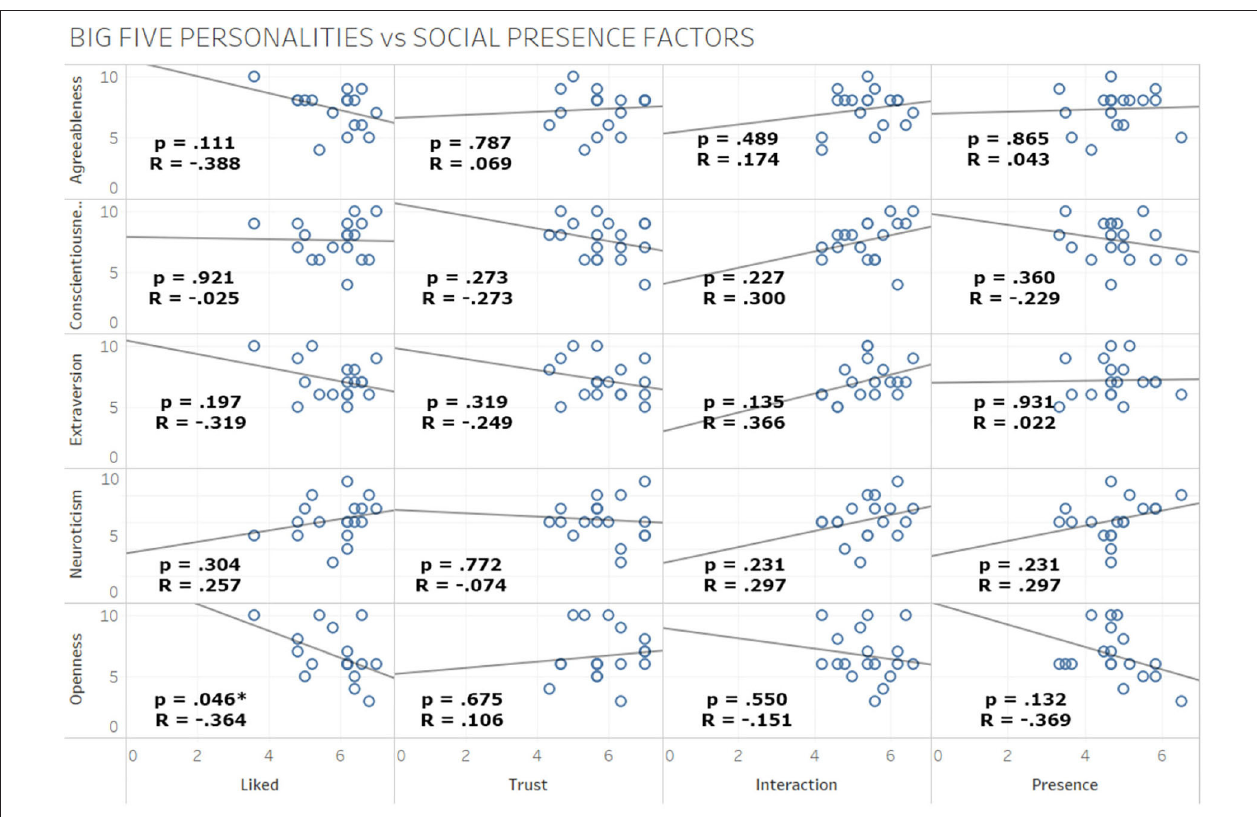
FIGURE 9 | Scatter plot of BIG FIVE personalities vs. social presence factors. * p < 0.05.